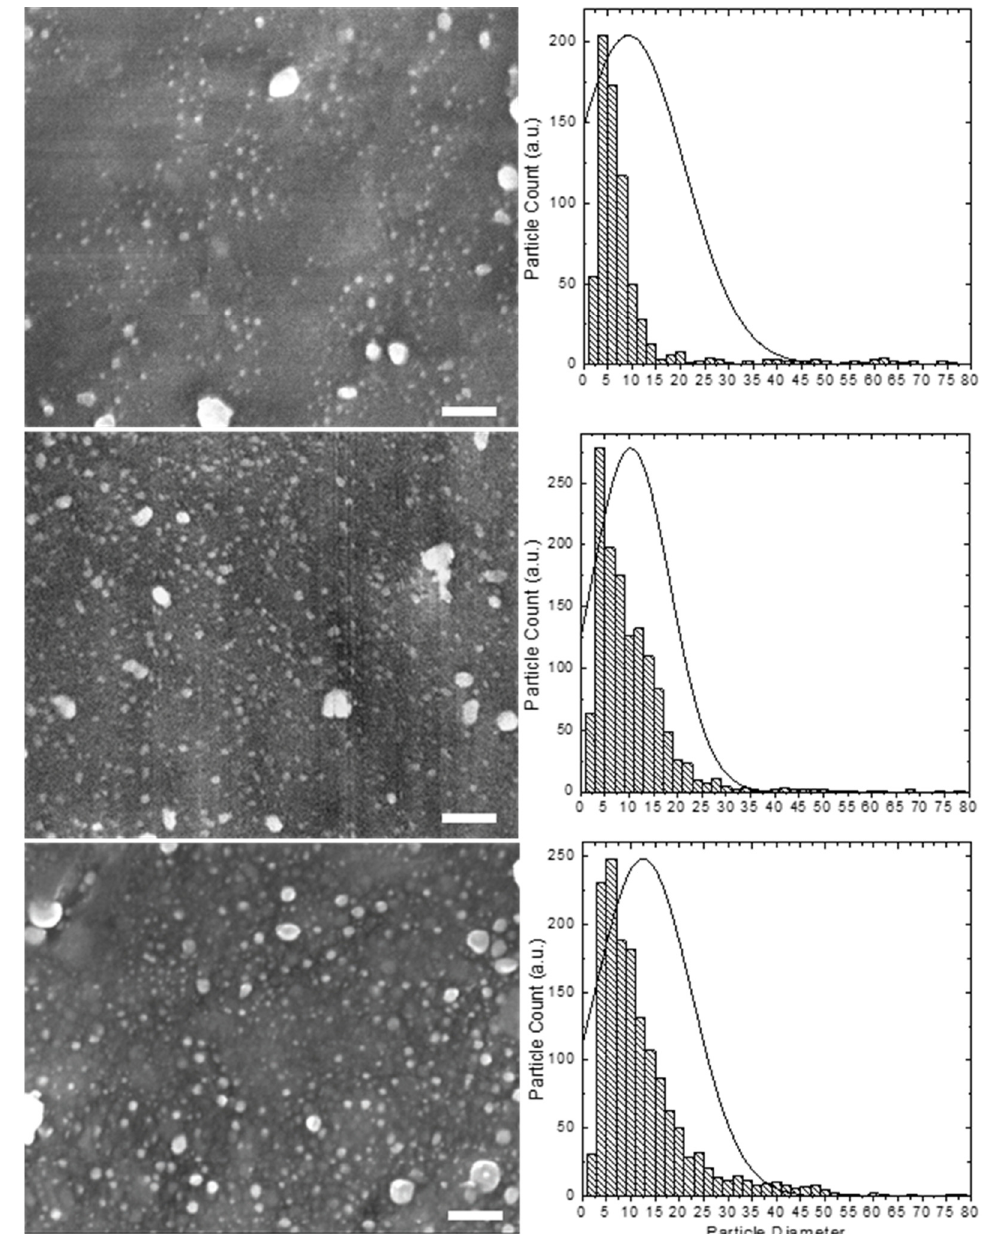
Figure 3. Top: Representative SEM images of the original unloaded resin beads. Bottom: Repre ‐ sentative SEM image ( a ) and EDS spectrum ( b ) and mapping ( c ) for Ag element on the resin beads embedded with Ag NPs.